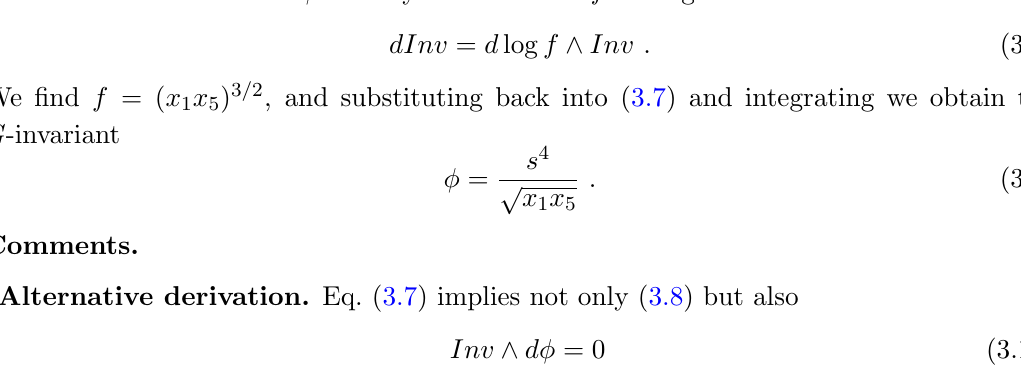
Figure 3 . The invariant (cid:30) can be interpreted geometrically as a function of the angle (cid:11) shown